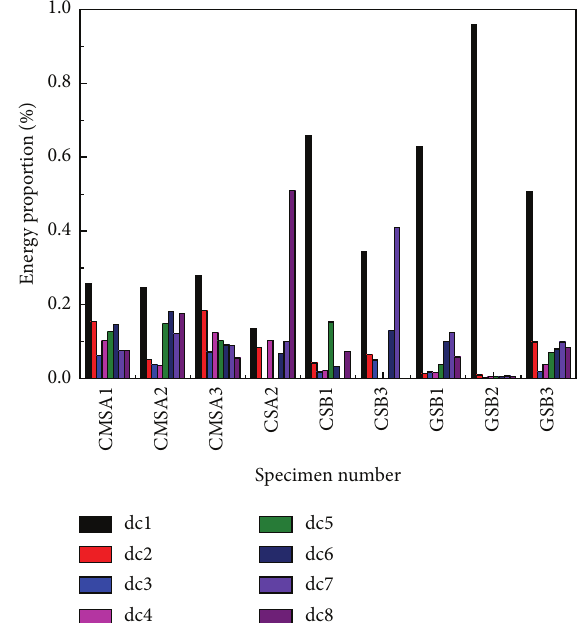
Figure 7: The event accumulation variation during the loading stage. Figure 8: Energy proportion of WPT best tree